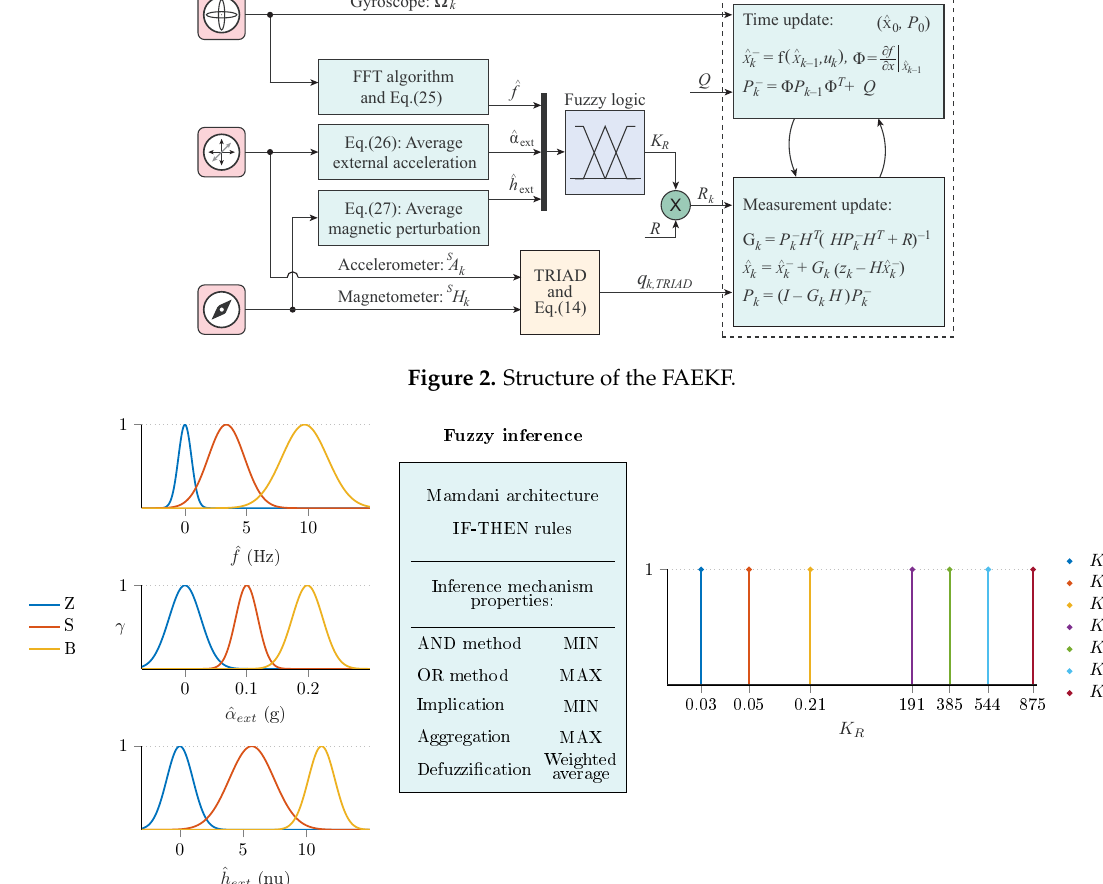
Figure 3. Properties of the applied fuzzy inference